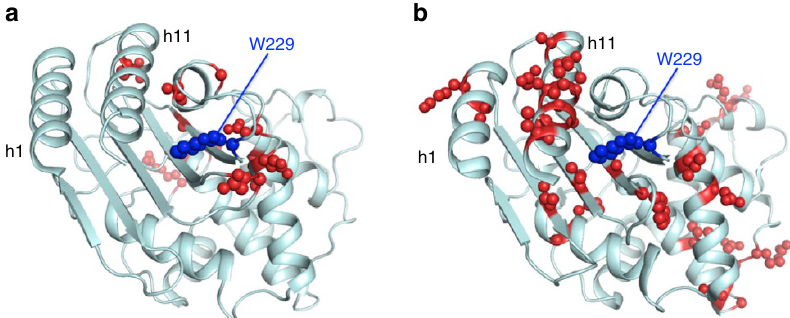
Figure 3 | NMR relaxation studies on modern and ancestral b -lactamases. The 3D-structures of ( a ) TEM-1 b -lactamase (PDB 1BTL) and ( b ) the b -lactamase encoded by the most probabilistic sequence at the GNCA node 11 (PDB 4B88) are displayed. The residues for which the relaxation rates cannot be explained without including a conformational exchange contribution (ref. 31 and this work) are highlighted in red. The h1 and h11 a -helices are labelled. The tryptophan residue at position 229 is highlighted in